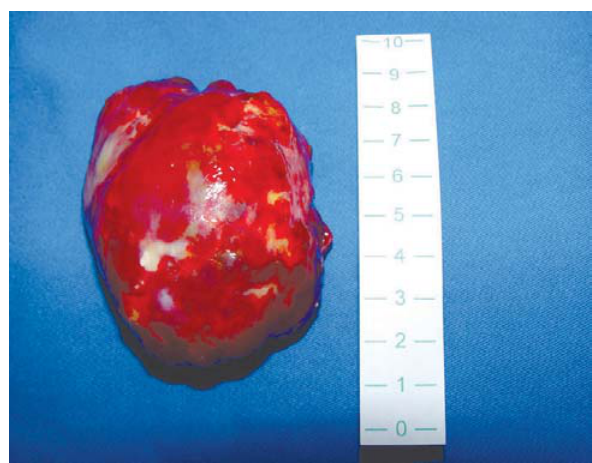
Fig. 2 - Aspecto e medida da neoplasia após ressecção